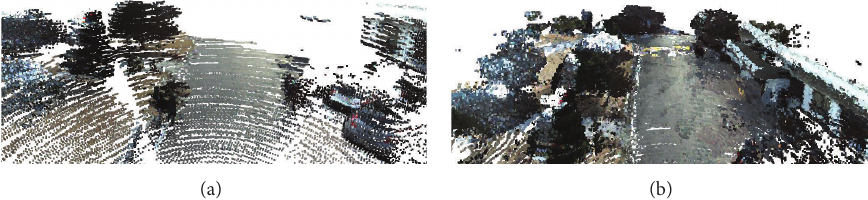
Figure 10: Fractions of generated voxel maps by using the flag map. (a) Registration from 1,808 packets of 3D point clouds. (b) Registration from 18,080 packets of 3D point clouds.